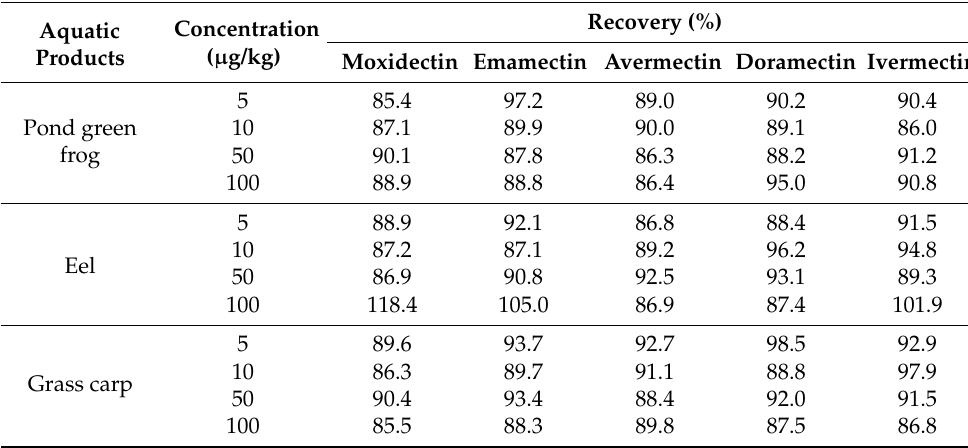
Table 6. Recoveries of five AVMs in aquatic products (n =